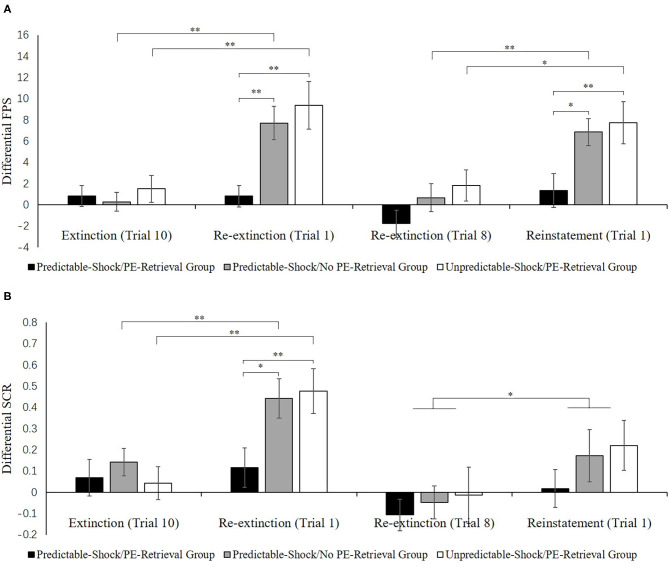
Mean differential FPS (A) and SCR (B) (CS+ minus CS–) during extinction (last trial), re-extinction (first trial; last trial), and reinstatement (first trial) for the experiment 1. Error bars represent SEM. *p < 0.05; **p < 0.01.